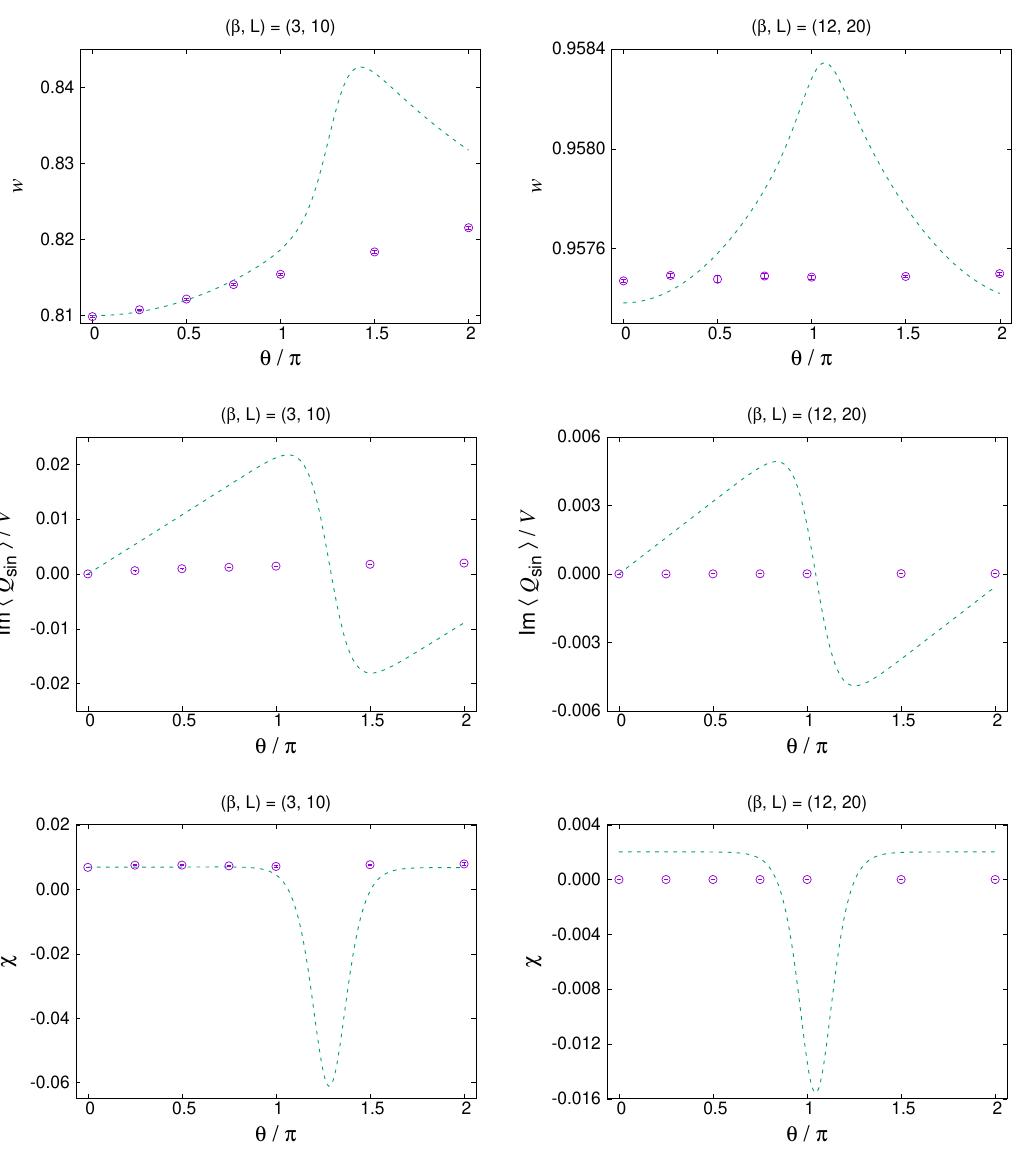
Figure 2 . The results for various observables obtained by the CLM for the non-punctured model with the sine de(cid:12)nition Q sin . The average plaquette (Top), the imaginary part of the topological charge density (Middle), the topological susceptibility (Bottom) are plotted against (cid:18) for ( (cid:12); L ) = (3 ; 10) (Left) and (12 ; 20) (Right). The exact results for the same ( (cid:12); L ) are shown by the dashed lines for